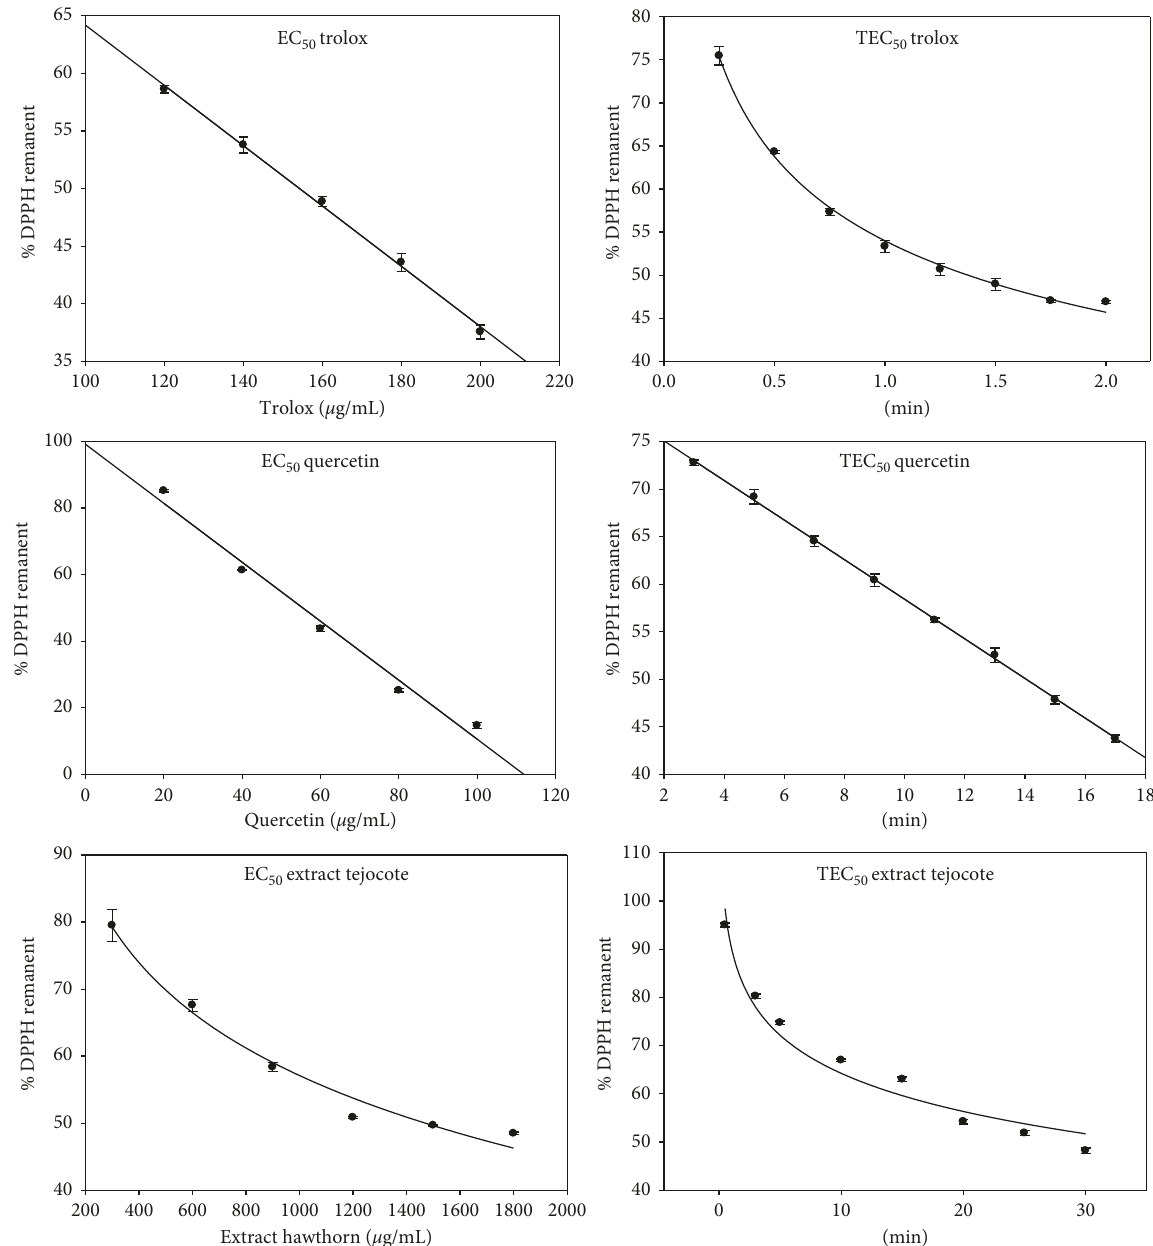
Figure 3: Percentage of remnant DPPH against the standard concentration was plotted in an exponential regression to obtain the amount of antioxidant necessary to decrease the initial DPPH concentration by 50% (EC 50 ) and the time needed to reach the steady state for EC 50 (TEC 50 ). The results are shown as the mean ± SD ( n �